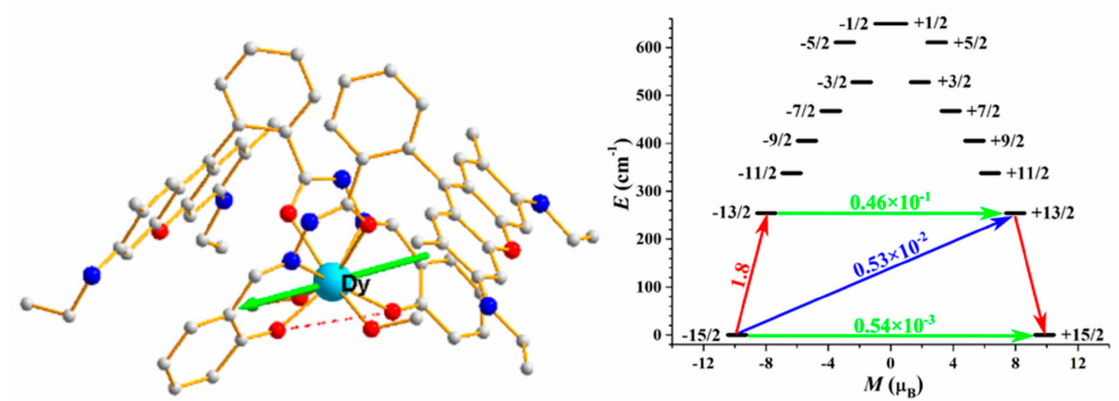
Figure 5. The alignment of the anisotropic axis for the central Dy(III) ion in Complex 1 ( left ). Magnetization blocking barriers in 1 ( right ): the thick black lines represent the KDs as a function of their magnetic moment along the magnetic axis; green lines correspond to diagonal QTM; blue lines represent off-diagonal relaxation process; the numbers at each arrow stand for the mean absolute value of the corresponding matrix element of transition magnetic